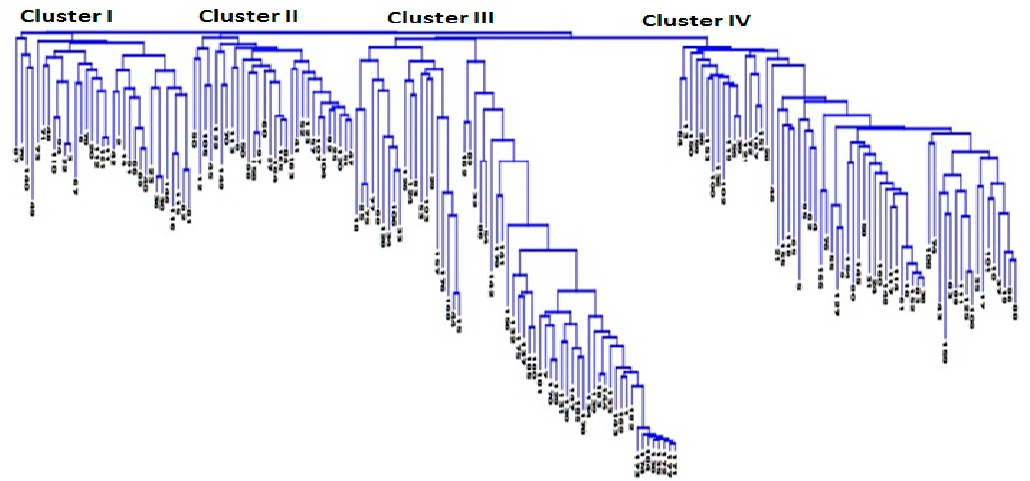
Figure 4. The neighbor joining cluster analysis using DArTseq-SNP markers for grouping 186 chickpea genotypes.